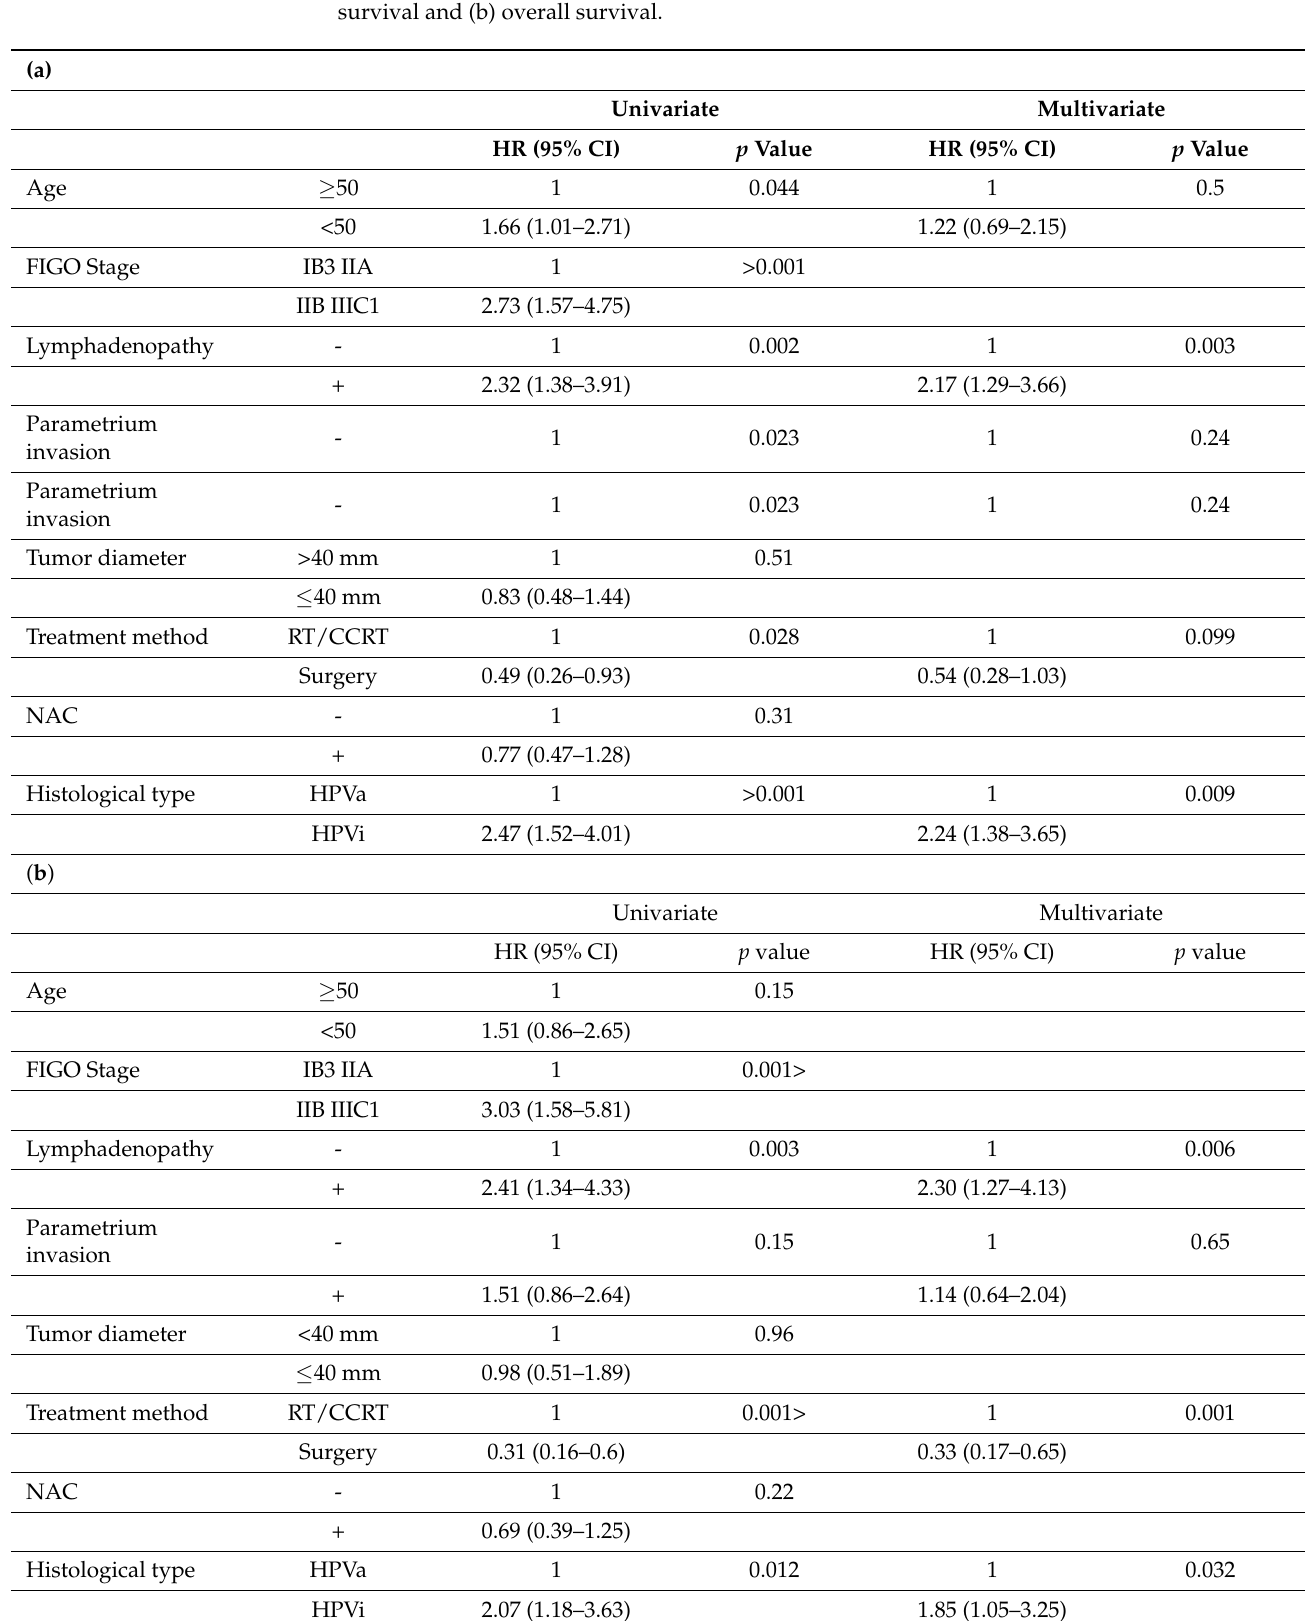
Table 2. Analysis of prognostic factors by univariate and multivariate analysis: (a) progression-free survival and (b) overall